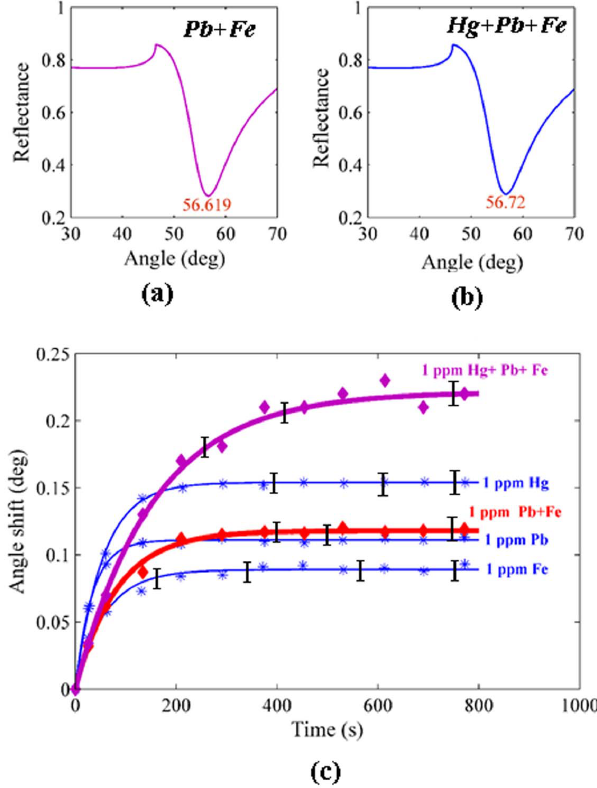
Figure 11. SPR signal and sensogram related to mixture of a) Pb and Fe ions at saturation value; b) Hg,Pb and Fe ions at saturation value c) Sensogram for detection of ions in the